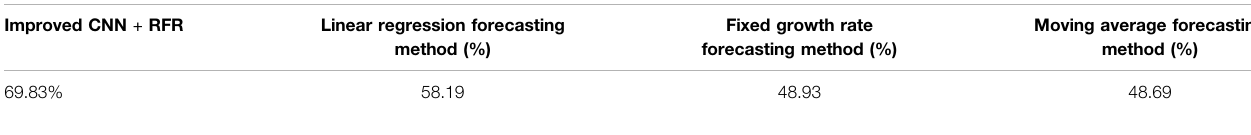
TABLE 7 | The proportion of distribution transformer number in the error interval of 0 –